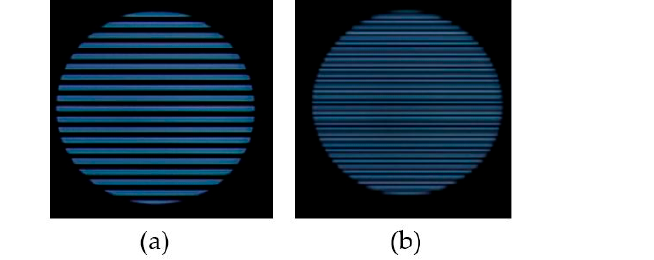
Figure 20. Data rate performance of 2FSOOK.